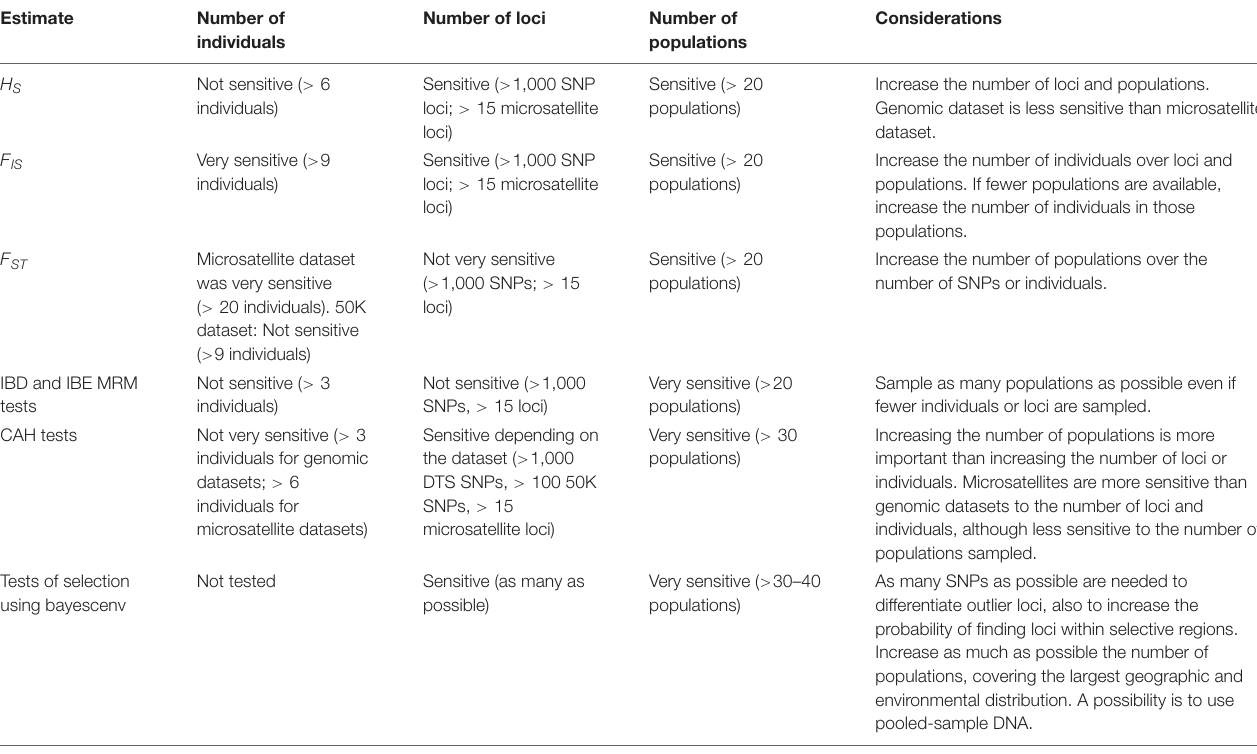
TABLE 3 | Recommendations for sampling designs depending on study